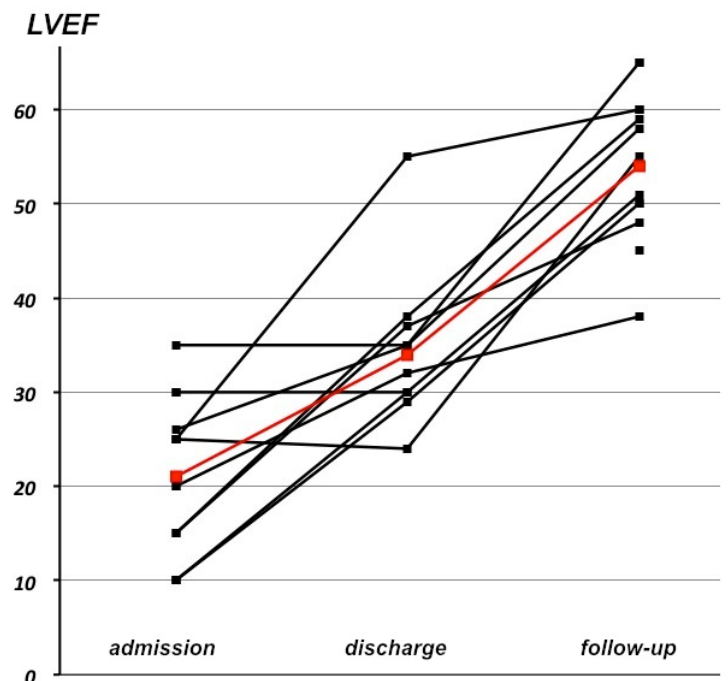
Figure 2. Evolution of LVEF between admission, discharge, and follow-up (red = mean).